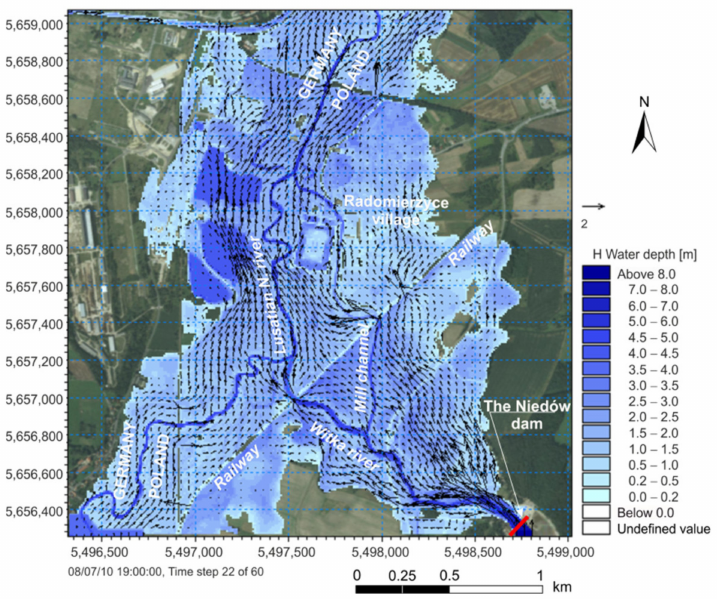
Figure 11. Simulated water depth and flow velocity vectors downstream from the Nied ó w dam (Polish UWPP 2000 Reference system (m)). The flood wave hit first the railway embankment with two bridges (on the Witka river and the Mill channel) running diagonally, then the Radomierzyce village (in the village center is a castle surrounded by a